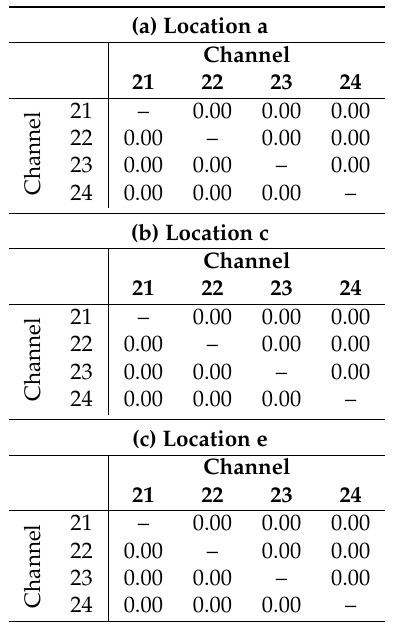
Table 2. p -values of Welch’s two-sample t -tests that check similarity of distributions of RSS measured on different